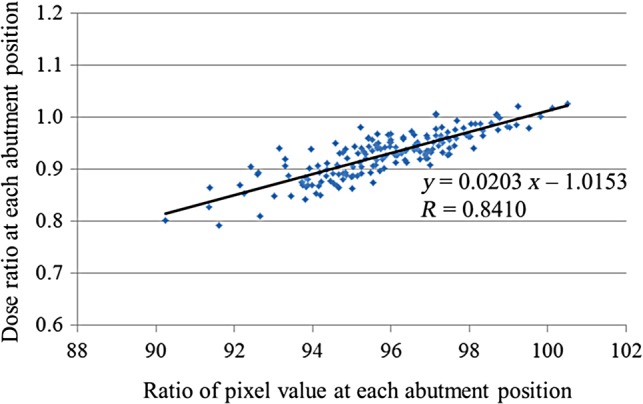
Relationship between dose ratios and pixel value ratios at each MLC abutment position. The approximation formula is shown in the figure. The correlation coefficient was 0.8410, which indicated a strong correlation.